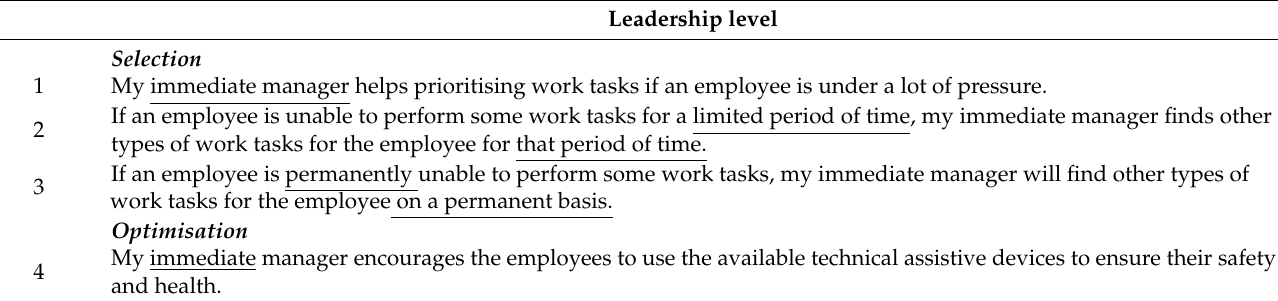
Table 1. The 29 SOC items included in the